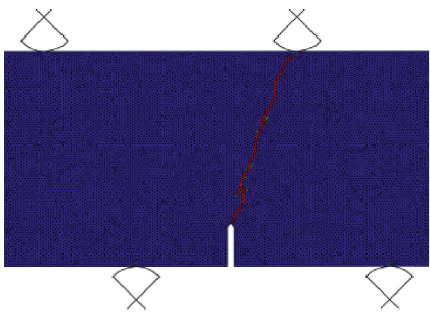
Figure 9: Calculation result of a pure cement mortar